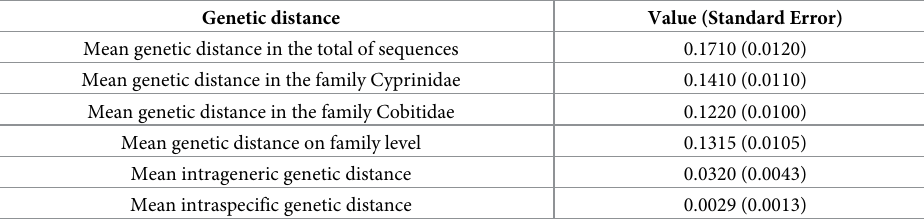
Table 1. Mean genetic distance in the total of sequences and mean genetic distance on a family, genus, and species level. In the parentheses is given the standard error of the genetic distance. Genetic distance Value (Standard Error) Mean genetic distance in the total of